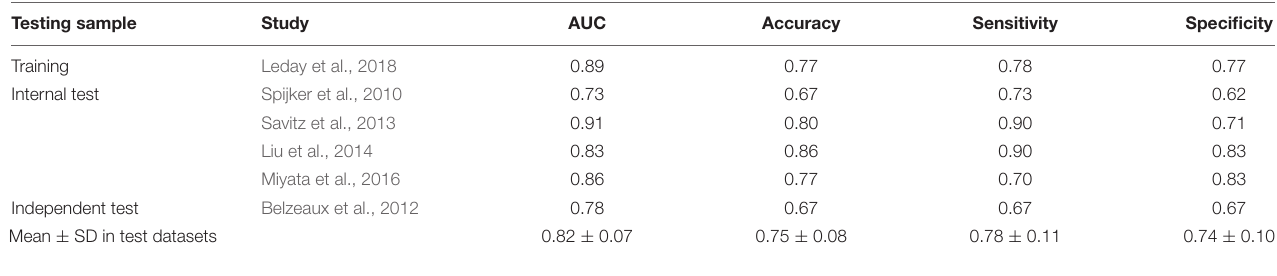
TABLE 4 | Evaluation of classification effect of the SVM model. Testing